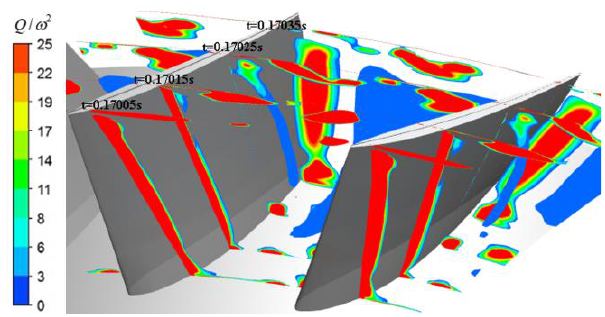
Figure 17. Snapshots of relative Q-criterion contours of R1 passage.